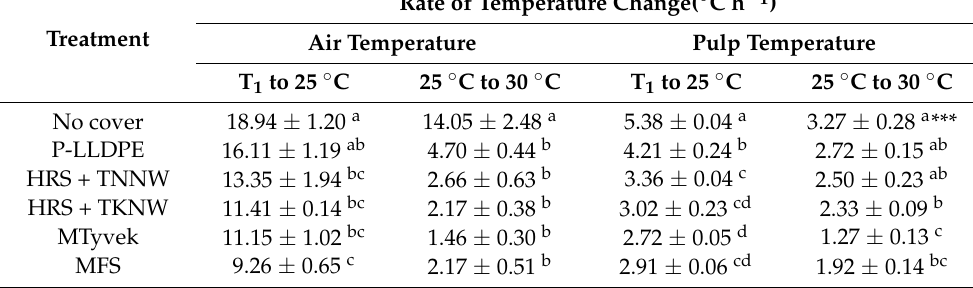
Note: Different letters indicate significant differences at p < 0.05. Values are mean ± S.E. from three (air temperature) and four (pulp temperature) replicates. *** It is noted that no cover treatment was estimated temperature at 28 ◦ C due to the maximum pulp temperature level at air temperature at 30 ◦